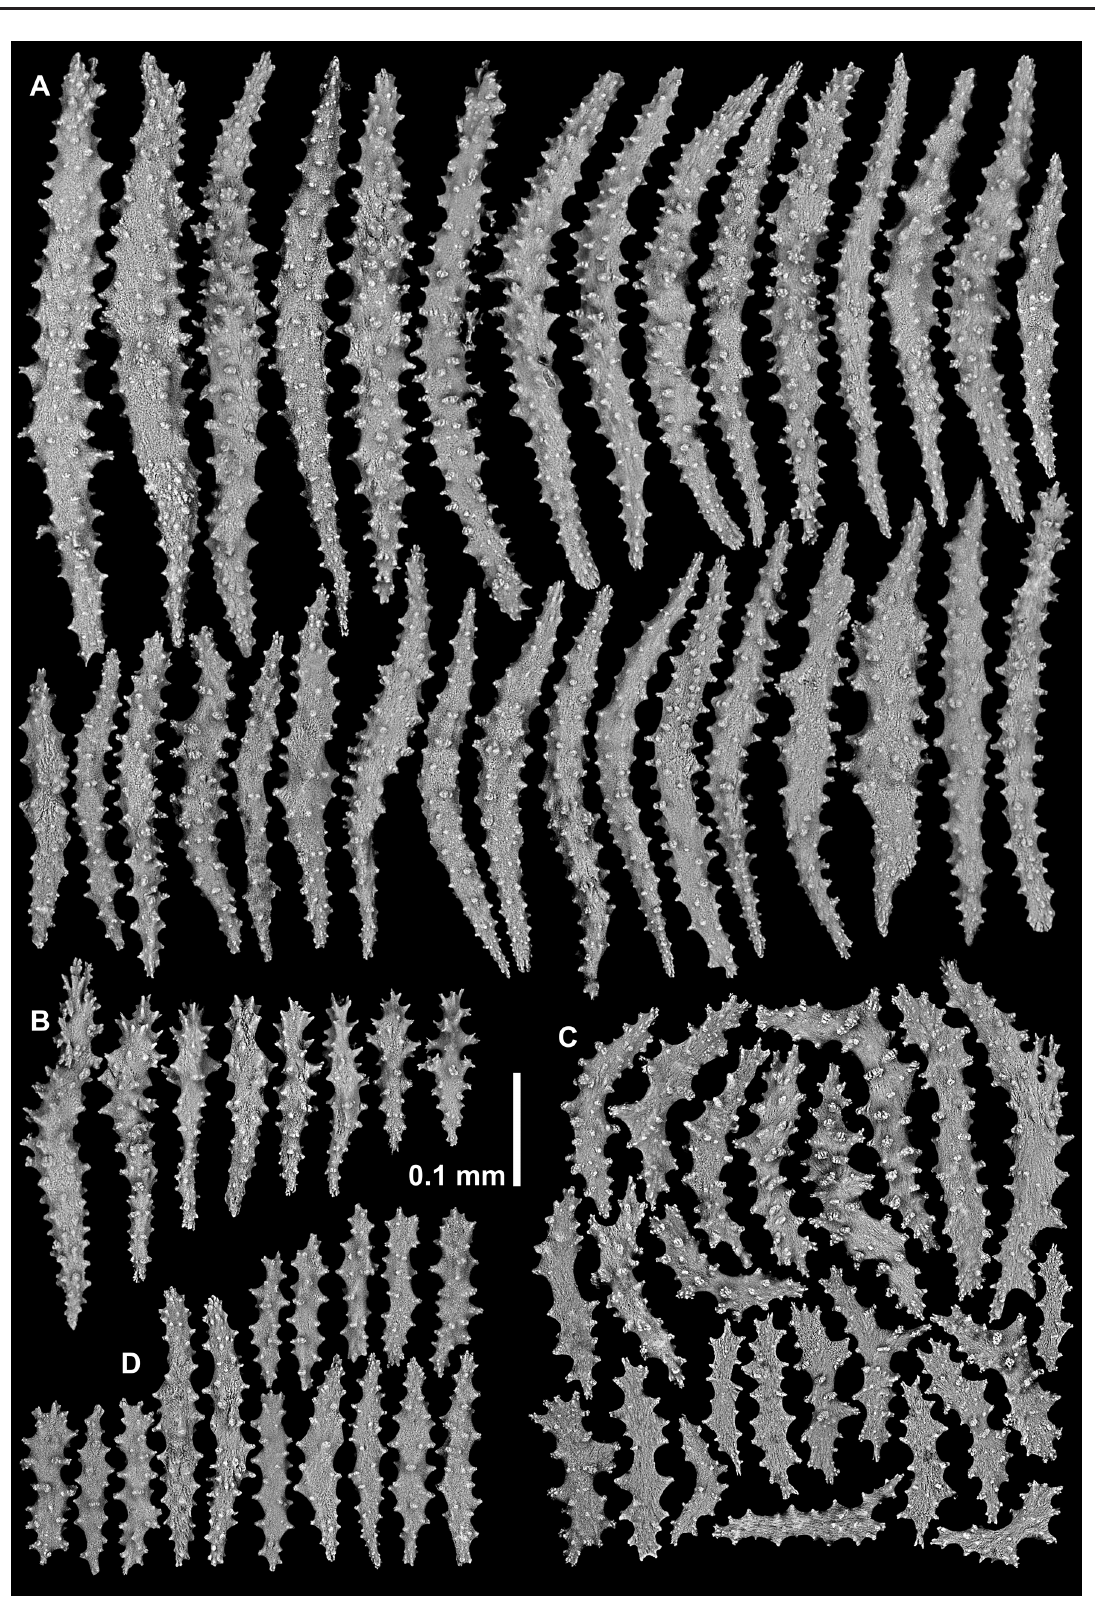
Fig. 32. Ushanaia fervens gen. et sp. nov., holotype (NIWA 156311), SEMs of sclerites. A . Collaret and points. B . Distal points. C . Tentacles. D . Polyp